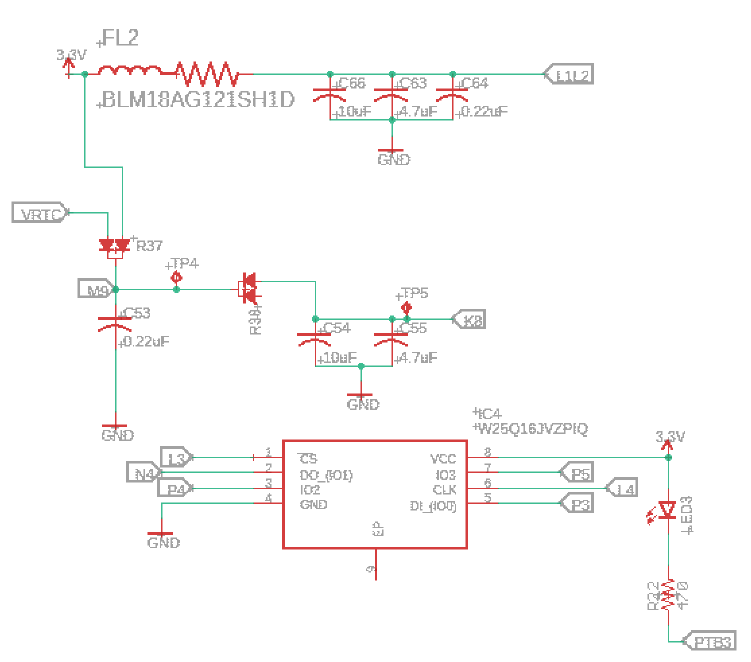
Figure 7. Serial flash memory schematic.